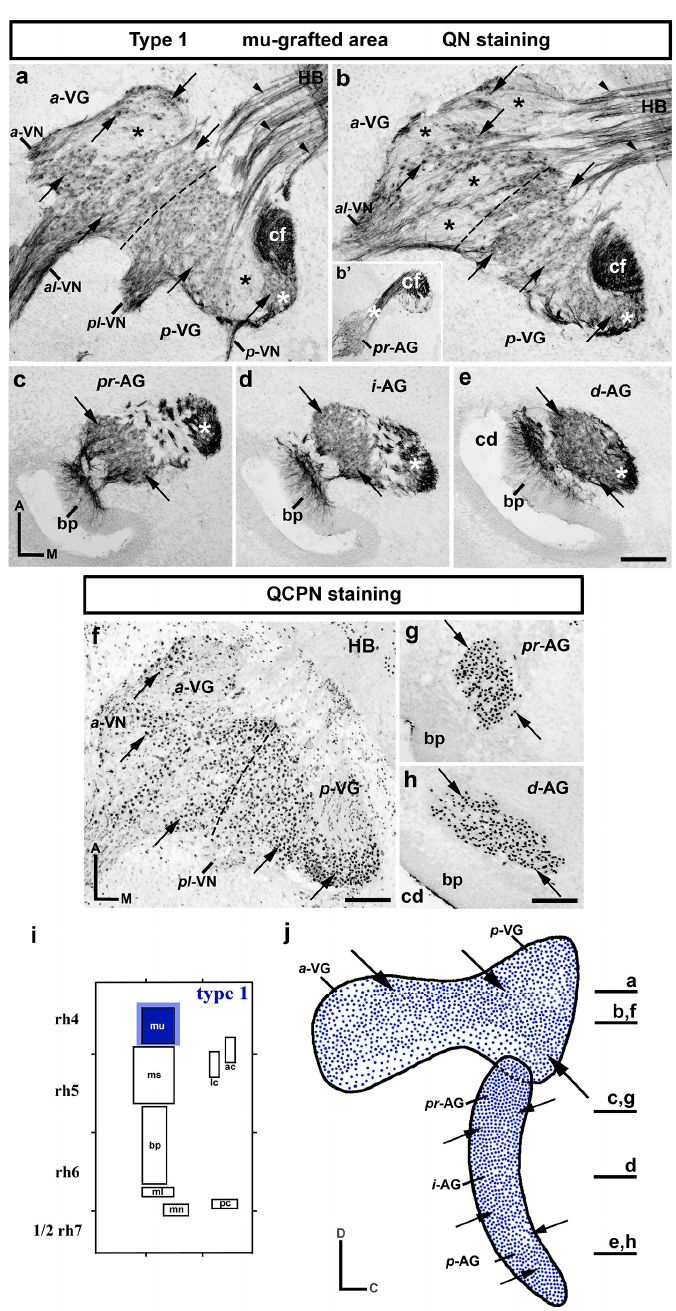
Figure 1. Graft-derived quail ganglionic neurons from the extended area of the macula utriculi (type-1 grafts; n = 9). ( a – h ) Serial horizontal sections stained with QN ( a – e ) and QCPN ( f – h ) antibodies through the vestibular (VG in ( a , b , f )) and acoustic (AG in ( c – e , g , h )) ganglia. ( a , b , f ) The dotted lines define the separation between the anterior and posterior lobes of the VG ( a -VG and p -VG). The four nerves arising from the VG were also indicated in ( a , b , f ) ( a -VN, al -VN, pl -VN, and p -VN). QN- and QCPN-stained grafted quail neurons were undoubtedly detected in the VG ( a -VG and p -VG; QN, arrows in ( a , b ); QCPN, arrows in ( f )). ( a , b ) The black asterisks indicate the areas of the VG devoid of mu-grated neurons. A higher density of grafted quail neurons was observed in the entire AG ( pr -AG, i -AG, and d -AG; QN, arrows in ( c – e ); QCPN, arrows in ( g , h )). ( a – e ) The white asterisks mark the QN-stained axonal fascicle from the basilar papilla (bp) and macula lagena, associated to the cochlear nerve fascicle (cf in ( b , b’ )). ( a , b )The arrowheads point to grafted-neuron axons towards the hindbrain (HB in ( a , b )). ( i ) Schematic representation of type-1 grafts performed at the 10-somite stage, taking a small portion of the chick otic containing the expanded sensory area of the macula utriculi (mu; dark and light blue areas). ( j ) Diagram showing a lateral view of the VG (dorsal) and